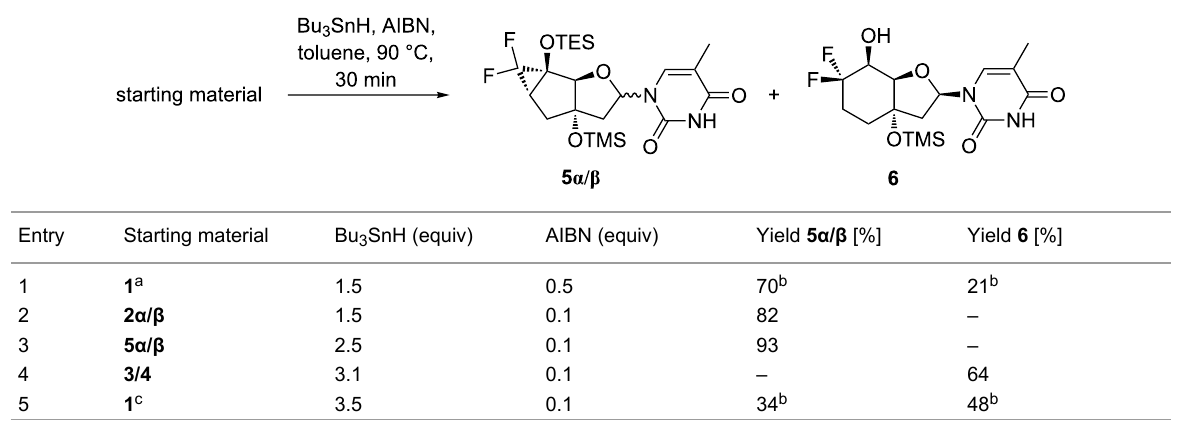
Table 1: Evaluation of the reaction mechanism for the production of bicyclic nucleoside 6